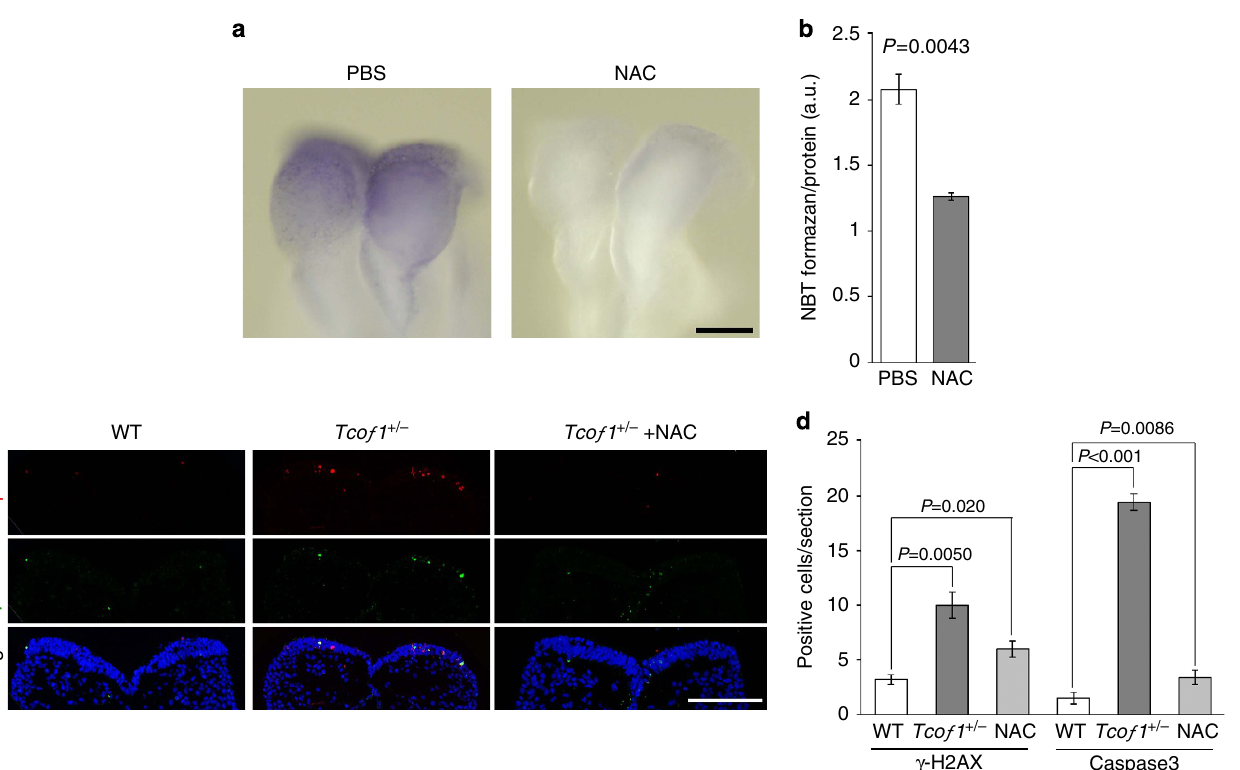
Figure 6 | Prevention of DNA damage and subsequent apoptosis through the pharmacological suppression of endogenous ROS. ( a ) Pregnant dams were treated with the NAC through intraperitoneal injection at E8.5. After 1h, endogenous oxidation was visualized by NBT staining. Scale bar, 100 m m. ( b ) Endogenous ROS levels were quantified by photometric assay of NBT formazan. The amount of NBT formazan in control (PBS; white bars) and NAC- treated embryos (grey bars) are shown as mean ± s.e. of three embryos. Statistical differences were assessed with Student’s t -test, and P values were shown. ( c ) Pregnant dams were treated with the NAC through intraperitoneal injection from E5.5 to E8.5. DNA damaged and apoptotic cells were detected by immunostaining of g -H2AX and cleaved Caspase 3 using cryosections of anterior neural plate (fore–midbrain level). Scale bar, 100 m m. ( d ) The number of g -H2AX-positive and cleaved Caspase 3-positive cells on a section prepared from the anterior neural plate (fore–midbrain level) of wild-type (white bars), Tco f 1 mutant (grey bars) and NAC-treated Tco f 1 mutant embryos (light grey bars) are shown as means ± s.e. of 12 sections prepared from four embryos. Statistical differences were assessed with Student’s t -test, and P values were shown.